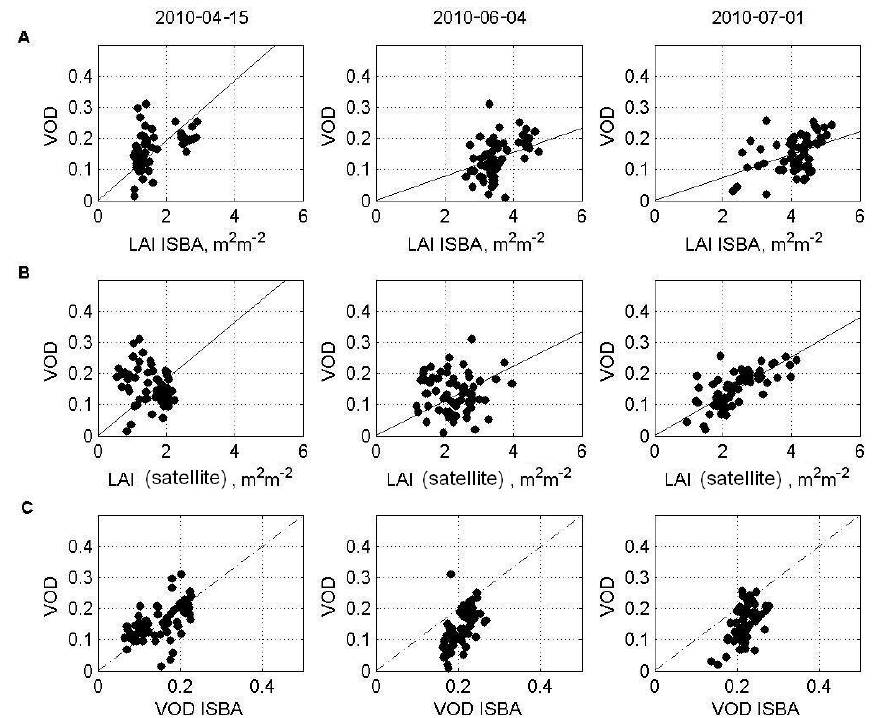
Fig. 8. Spatial correlation between the CAROLS VOD and (A) the ISBA-A-gs LAI, (B) the satellite-derived LAI, and (C) the VOD estimated from the ISBA-A-gs LAI and the forest fraction from ECOCLIMAP-II using the same b low parameter 0.09 for three dates in 2010 (from left to right): 15 April, 4 June, 1 July. The solid lines on plots (A) and (B) represent linear regression lines with forced zero intercept.